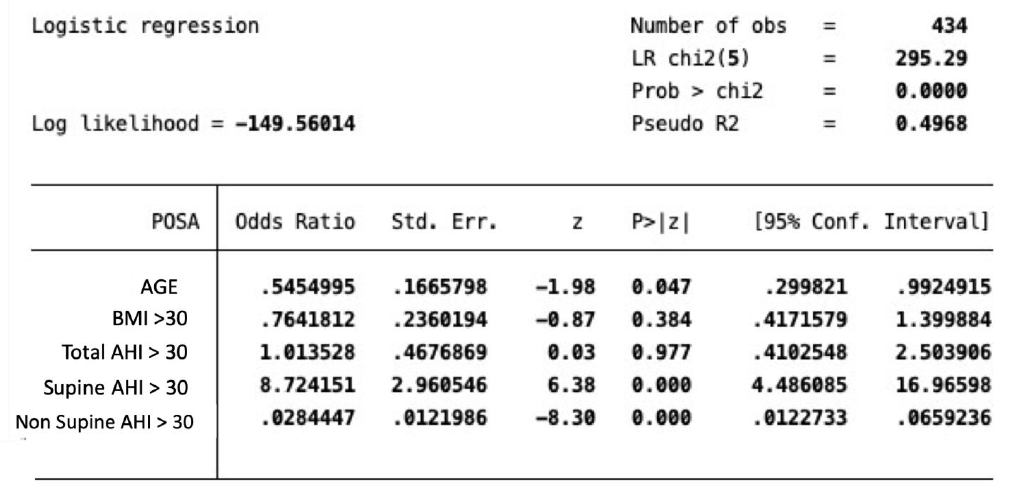
Figure 1. Multi-variable analysis of possible risk factors for POSA.